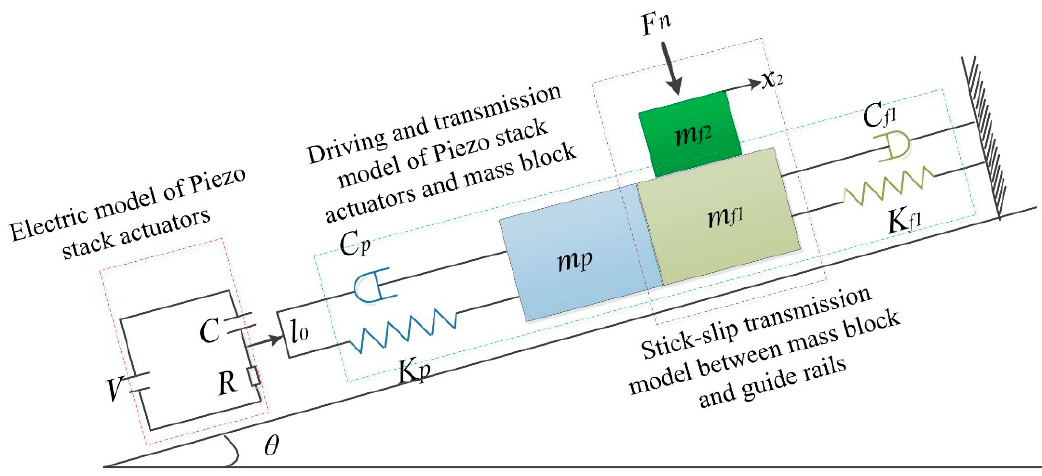
Figure 6. Dynamic model of the PASSNS.